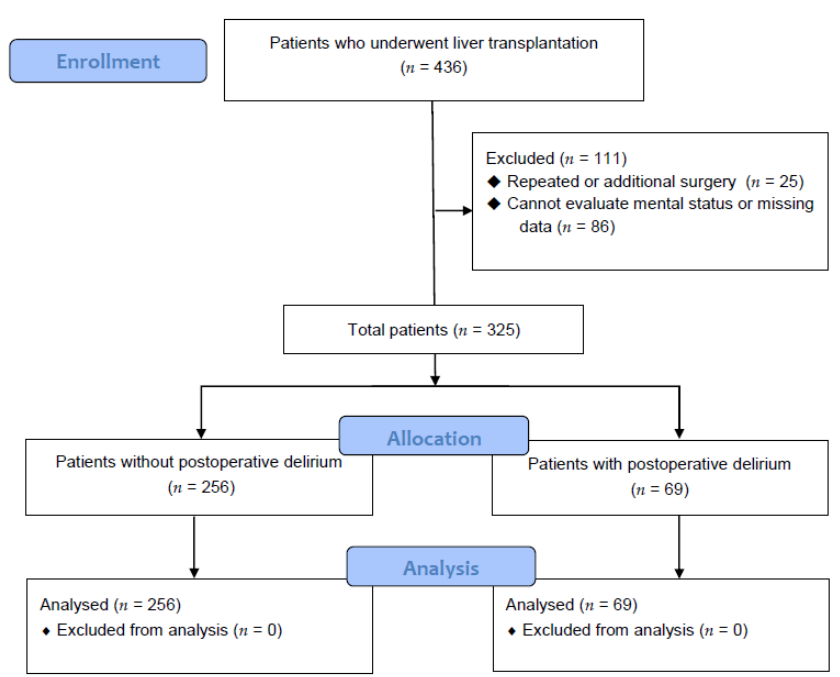
Figure 1. Flow diagram analyzing the effect of bilirubin on postoperative delirium in liver transplant patients.